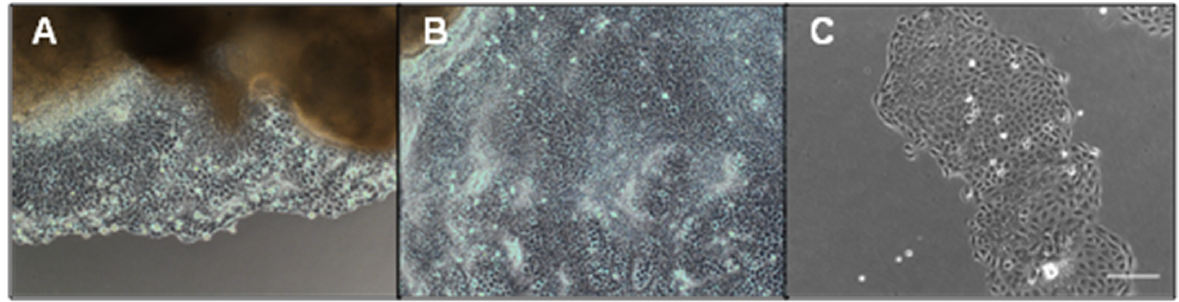
Figure A1. Primary goat mammary epithelial cells had typical epithelioid morphology. ( A ) GMECs moved out of tissue block after culture for 6 d; ( B ) GMECs moved out after culture for 10 d; ( C ) GMECs for passage 1. Scale bar = 200 μ m.